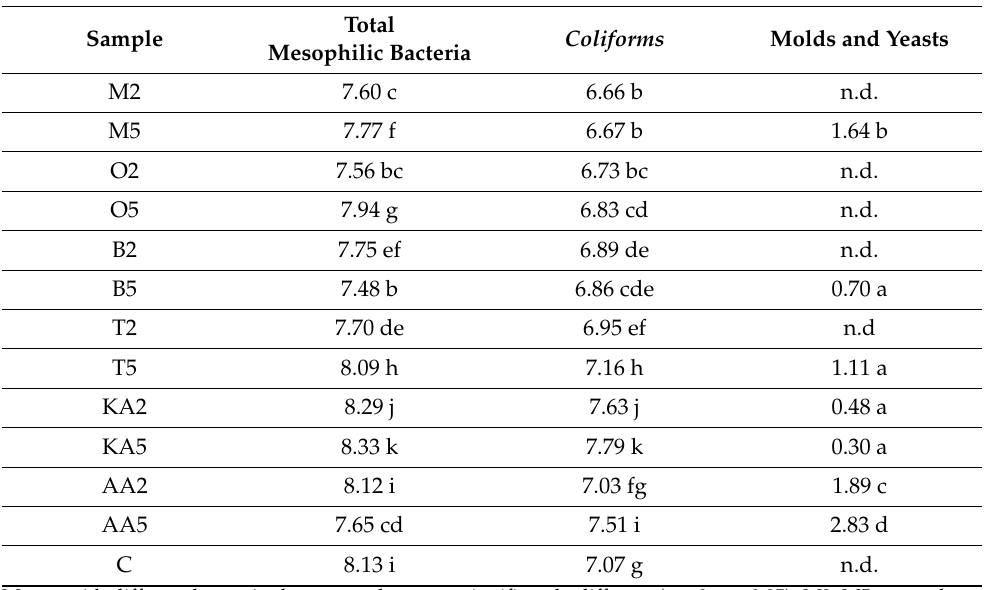
Table 4. Effect of postharvest treatment with functional solutions on the microbial quality of stored mung bean sprouts. Count of Microorganisms (log10 CFU/g f.m.) Sample